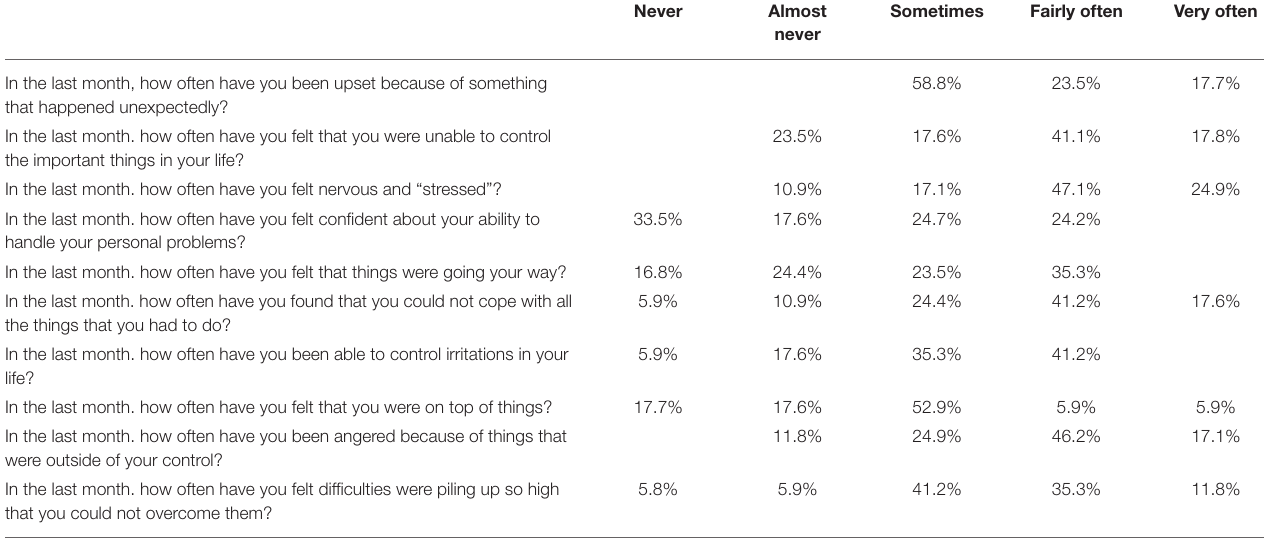
Never Almost Sometimes Fairly often Very often never